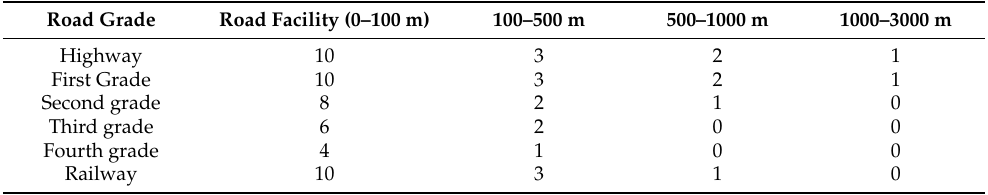
Table 2. Road grade * influences degree and scope parameter based on the previous study [30,31] and modified according to related research [43–45] and expert judgment.